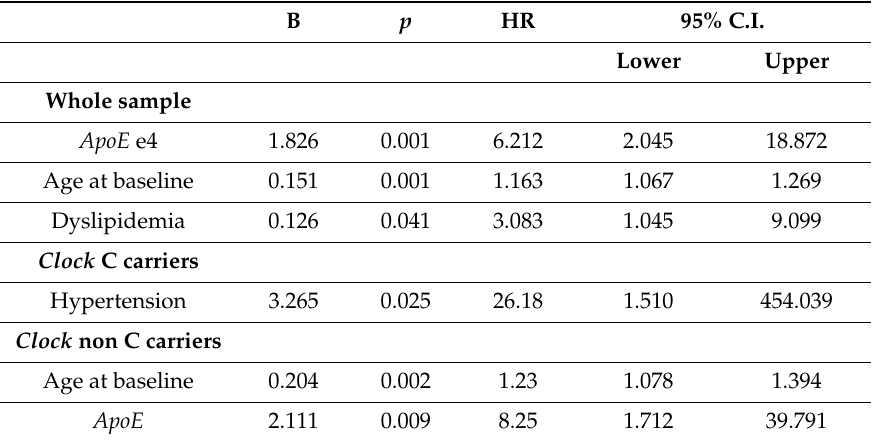
Table 4. Proportional hazards regression